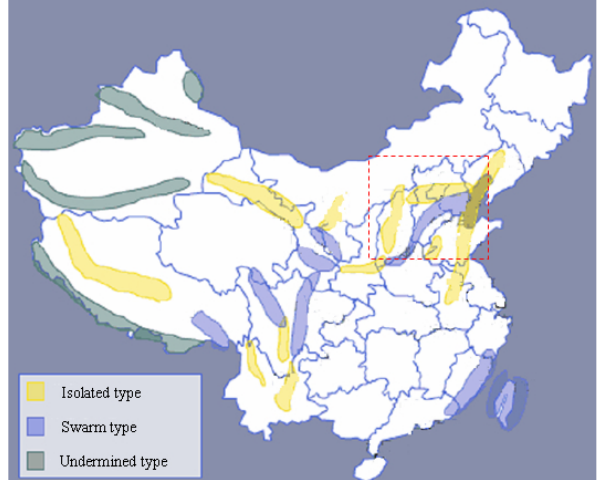
Fig. 5. The distribution of seismic belts in